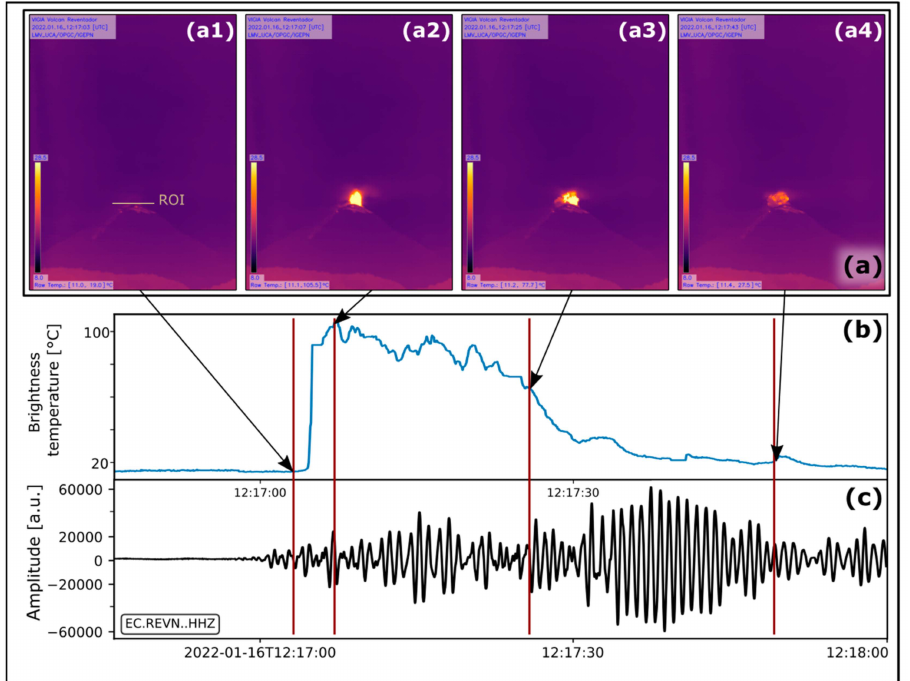
Figure 10. Thermal data recorded as video allow the analysis of explosions on a short timescale. In this example from the Reventador volcano, frames ( a ) extracted from the thermal video show the surficial state of the volcano: ( a1 ) before the plume appears over the crater; ( a2 ) at the moment when the temperature measured was maximal; ( a3 ) at the middle of the explosion; and ( a4 ) at the end of the explosion. Panel ( b ) show the timeseries of the maximal temperature inside the region of interest located just above the crater rim (ROI at ( a1 )), which can be compared with the record from the REVN seismic station located ~4 km from the active vent, ploted in panel ( c